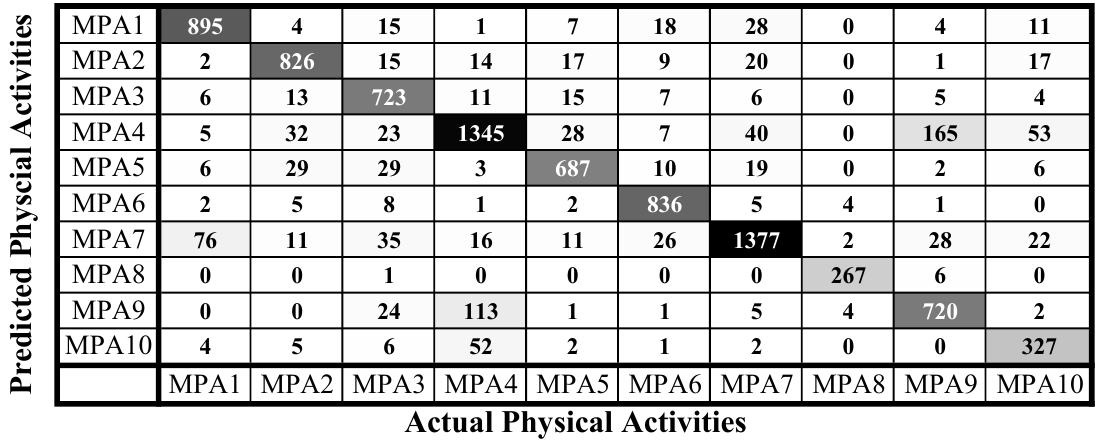
( c ) Confusion matrix for 70–30% data split Figure 6. Confusion matrices achieved with a RF classifier where the training and test sets are split in various